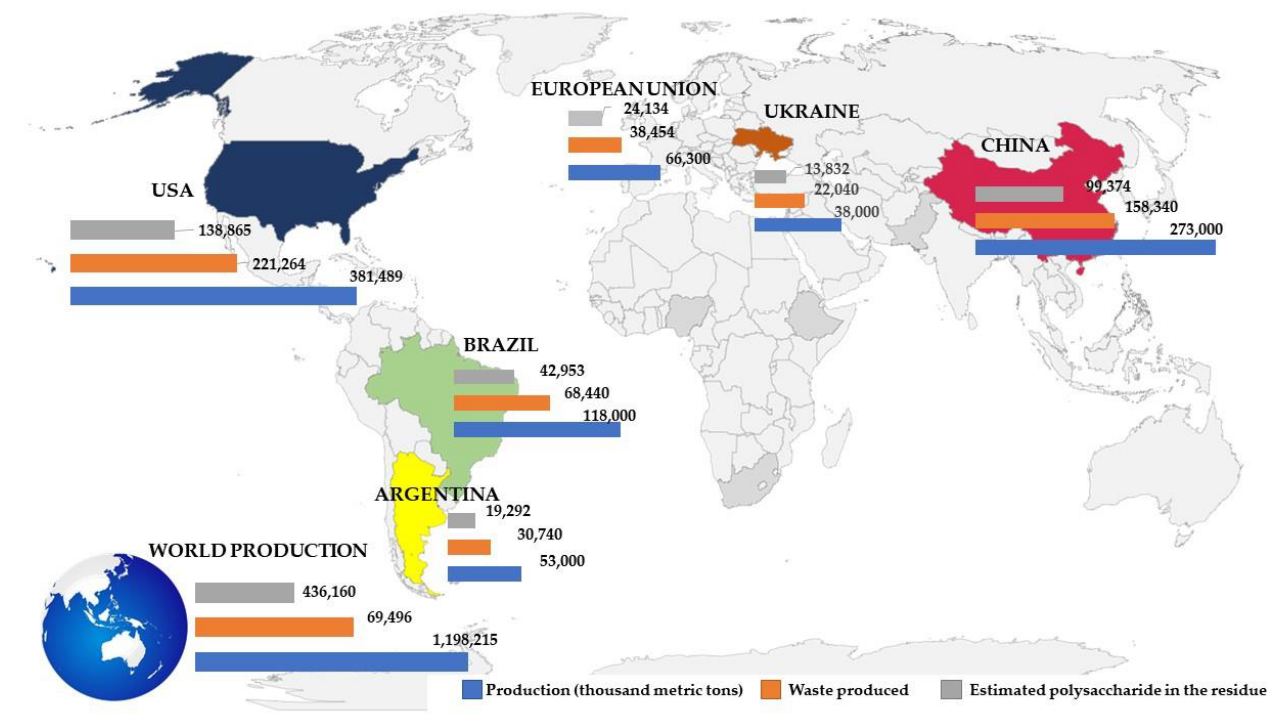
Figure 3. Main global producers of maize in the year of 2020–2021: total production (in thousand metric tons, blue bars), waste production (orange bars), and estimated polysaccharide residues (gray bars).